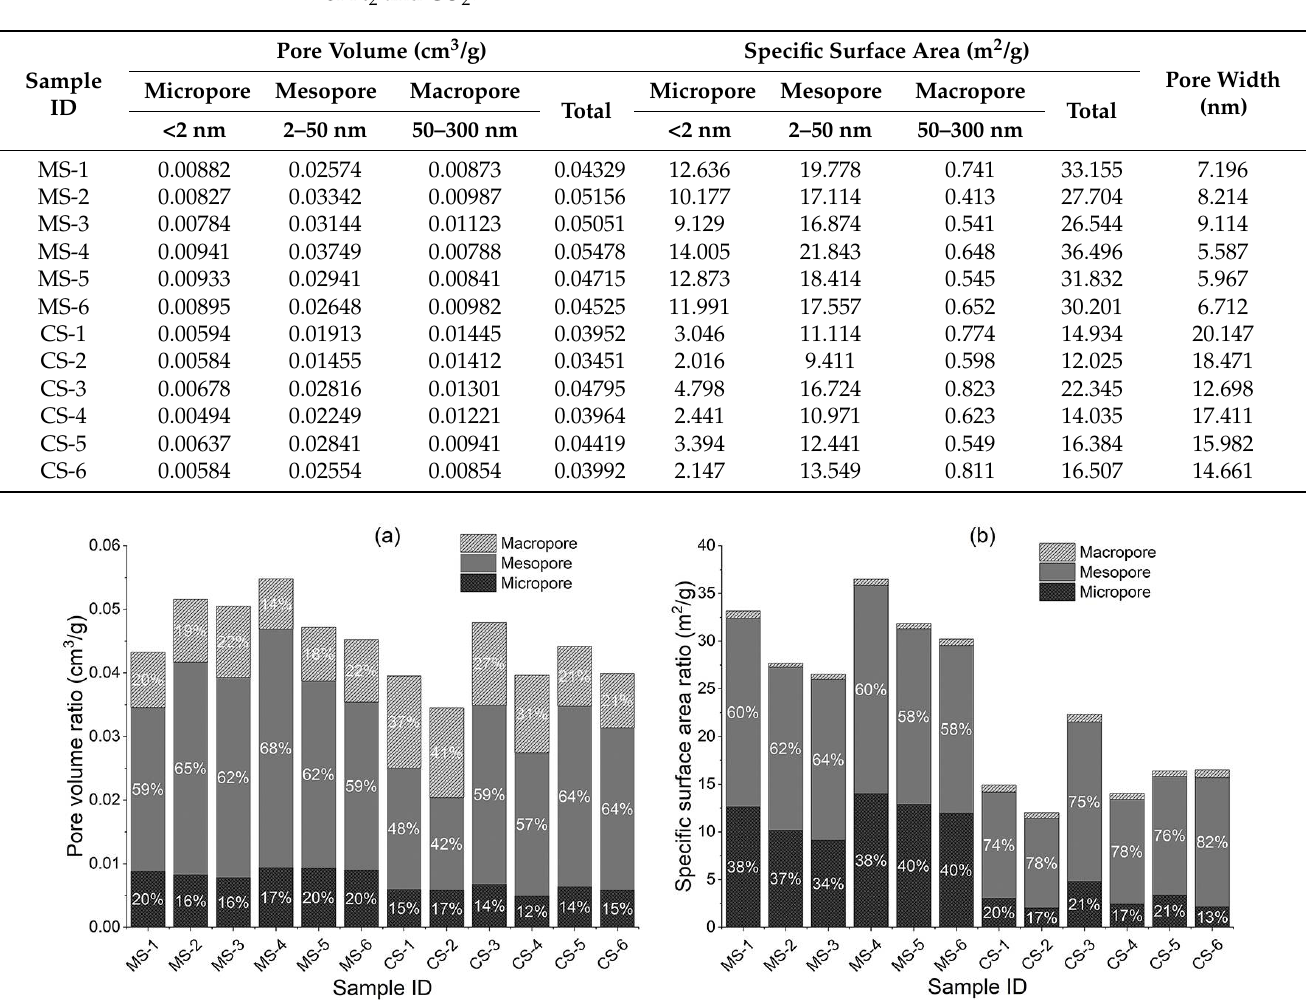
Table 3. Pore structure parameters of marine and continental shale based on isothermal adsorption of N 2 and CO 2 .